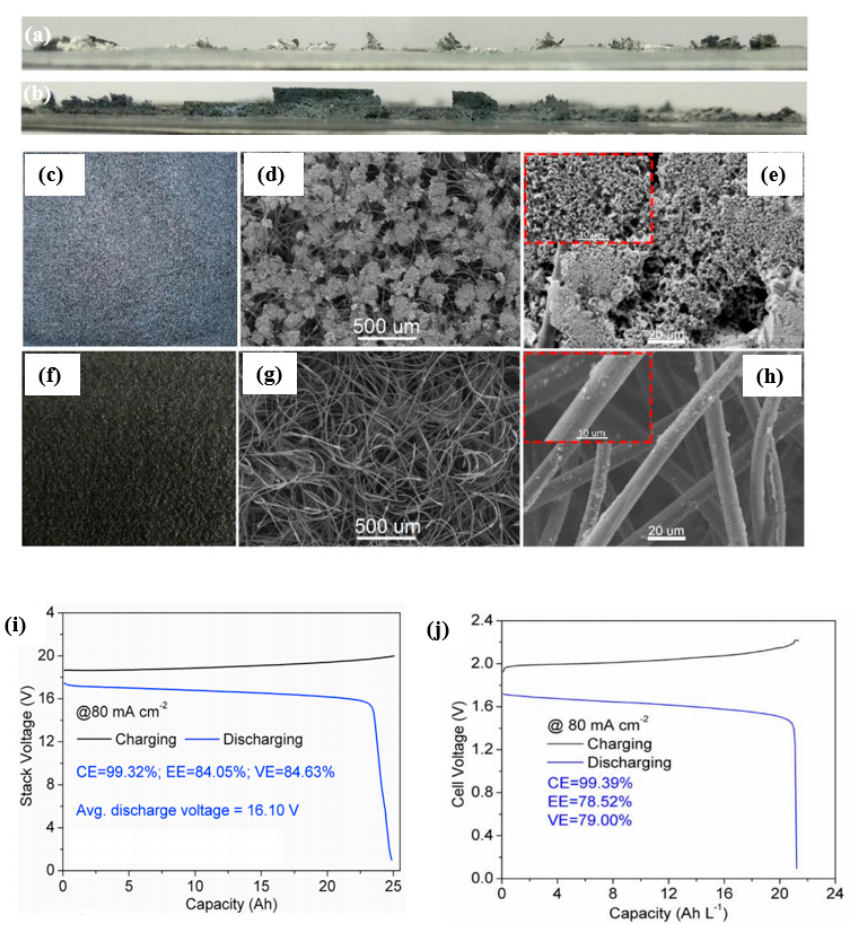
Figure 5. ( a , b ) The optical image of the zinc plate electrode (cross-section view) after charging ( a ) and discharging ( b ); ( c – h ) morphologies of the carbon felt electrode after charging ( c – e ) and dis- charging ( f – h ) (magnified SEM images in e and h ); ( i , j ) charge–discharge curve of the alkaline